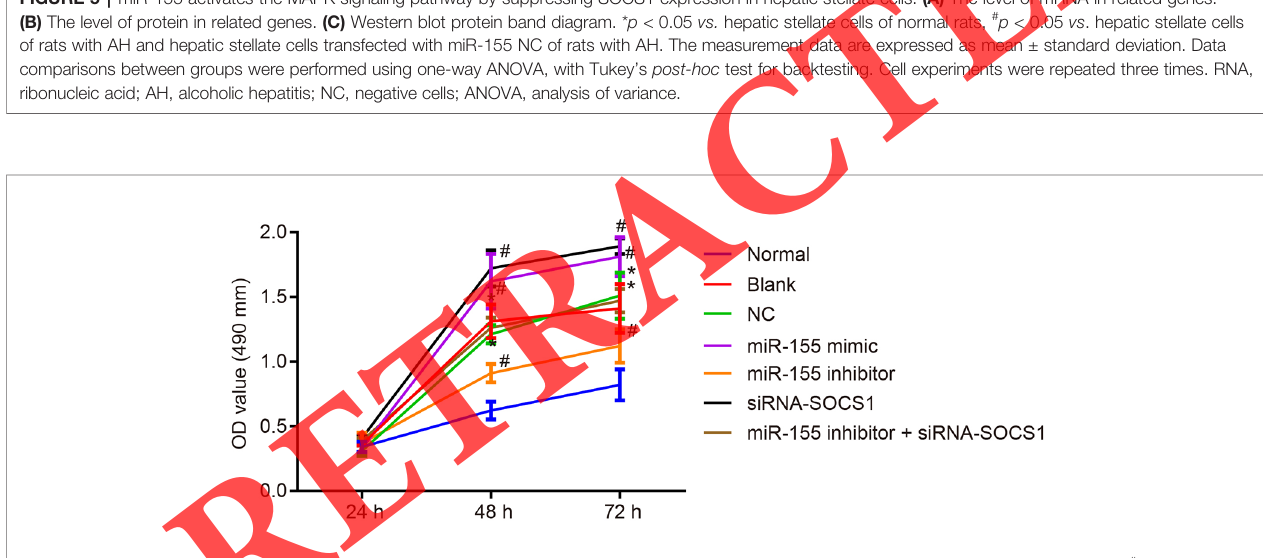
FIGURE 6 | miR-155 upregulation and SOCS1 silencing promote the cell viability of hepatic stellate cells. * p < 0.05 vs . normal hepatic stellate cells, # p < 0.05 vs . cells without any treatment and cells treated with miR-155 NC. The measurement data are expressed as mean ± standard deviation. Data comparison between groups at different time points was performed by repeated-measures ANOVA with post-testing Bonferroni correction. The cell experiment was repeated three